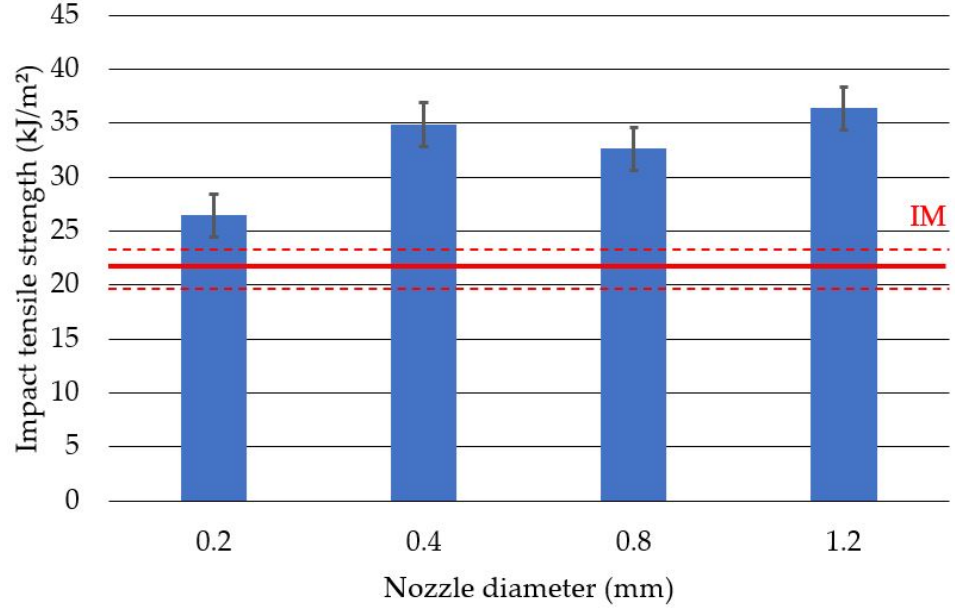
Figure 12. Average impact tensile strength values with standard deviation for specimens produced with different nozzle diameters. IM—average value obtained for injected specimens.